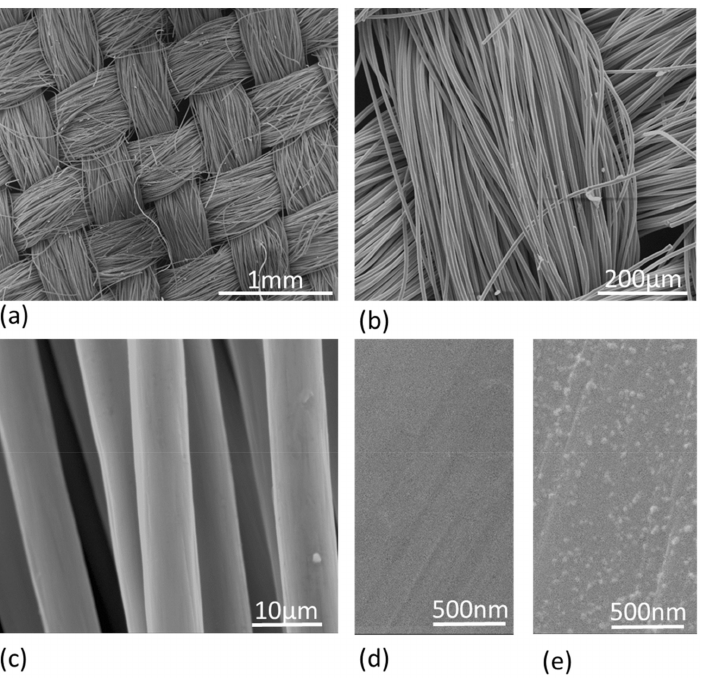
Figure 1. SEM images of a plain CC fabric at low ( a , b ), medium ( c ) and high ( d ) magnification. High magnification image of CC-Cu showing the copper nanoparticles ( e ).